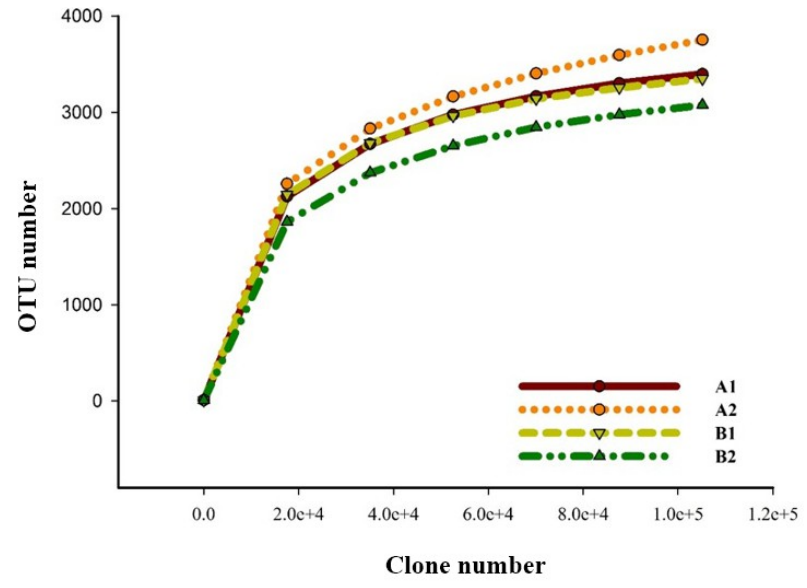
Figure 5. Rarefaction analysis of OTUs (operational taxonomic units).